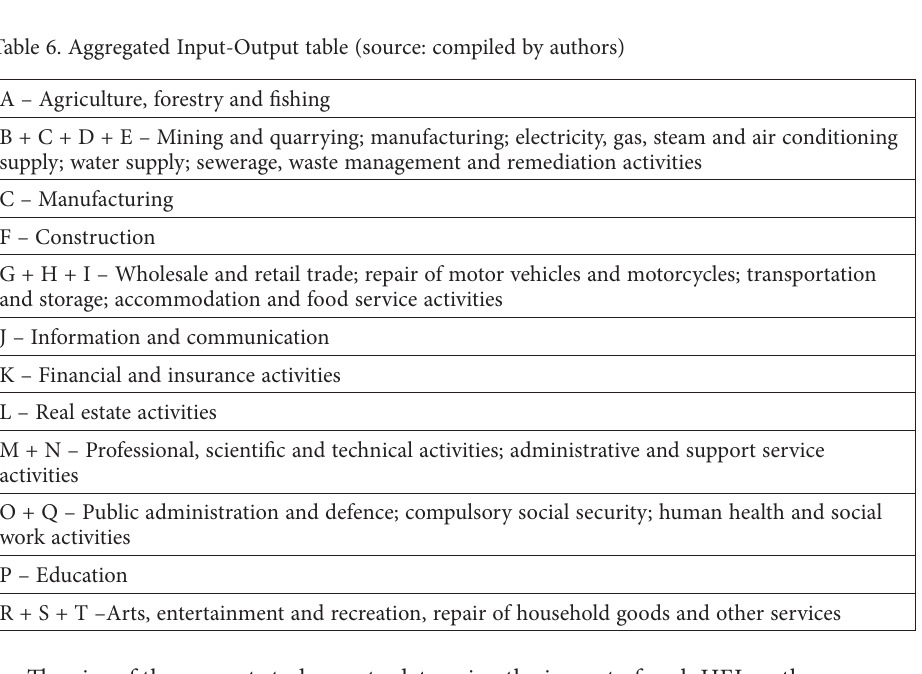
Figure 1. Raw Type II output multipliers of HEIs in Lithuania (source: compiled by authors)